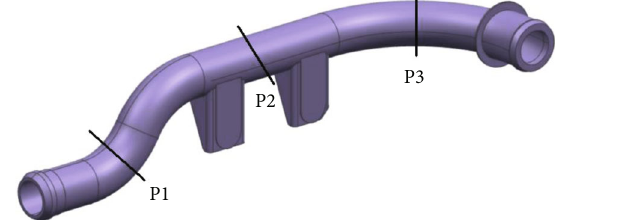
Table 1: DOE of Opt